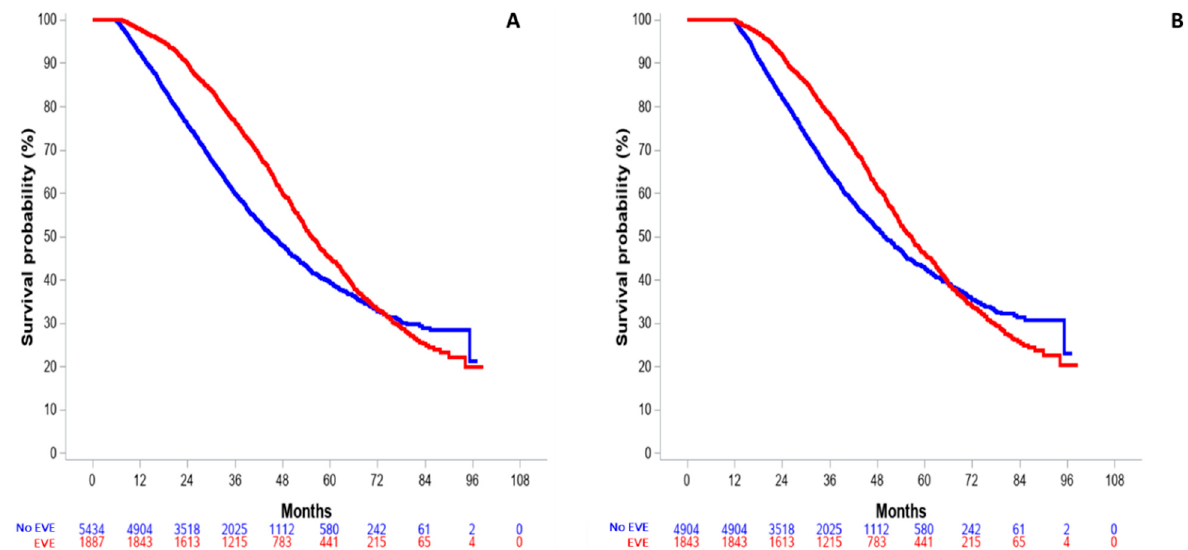
Figure 3. Landmark analysis of overall survival in the entire population, according to minimal follow-up. ( A ) 6-month landmark OS. ( B ) 12-month landmark